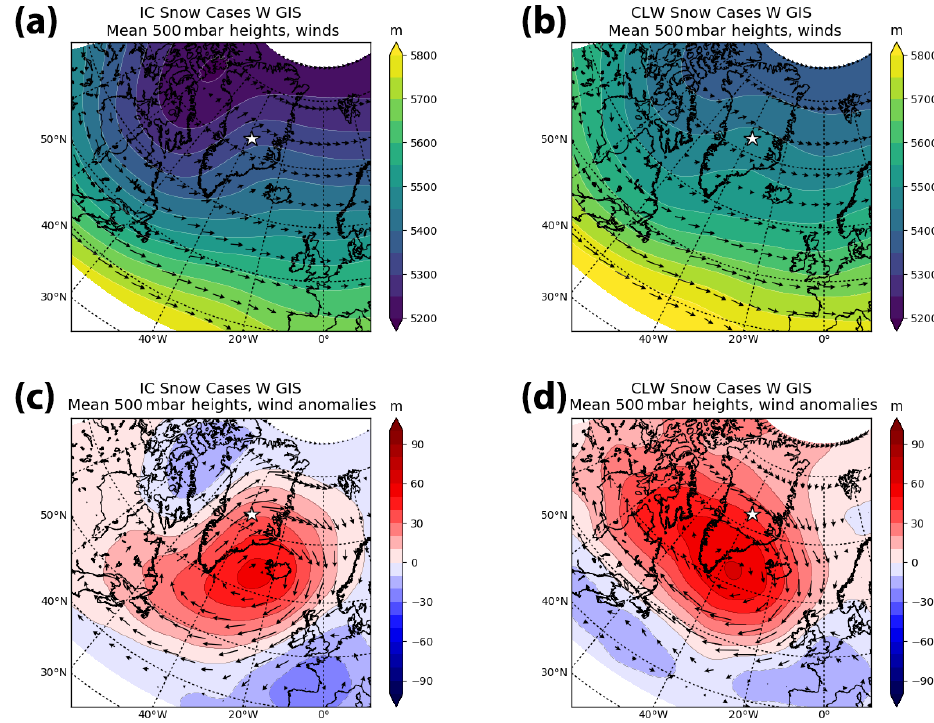
Figure 16. As in Fig. 14 but for the western GrIS: basins 6.1, 6.2, 7.1, 7.2, 8.1, and 8.2.